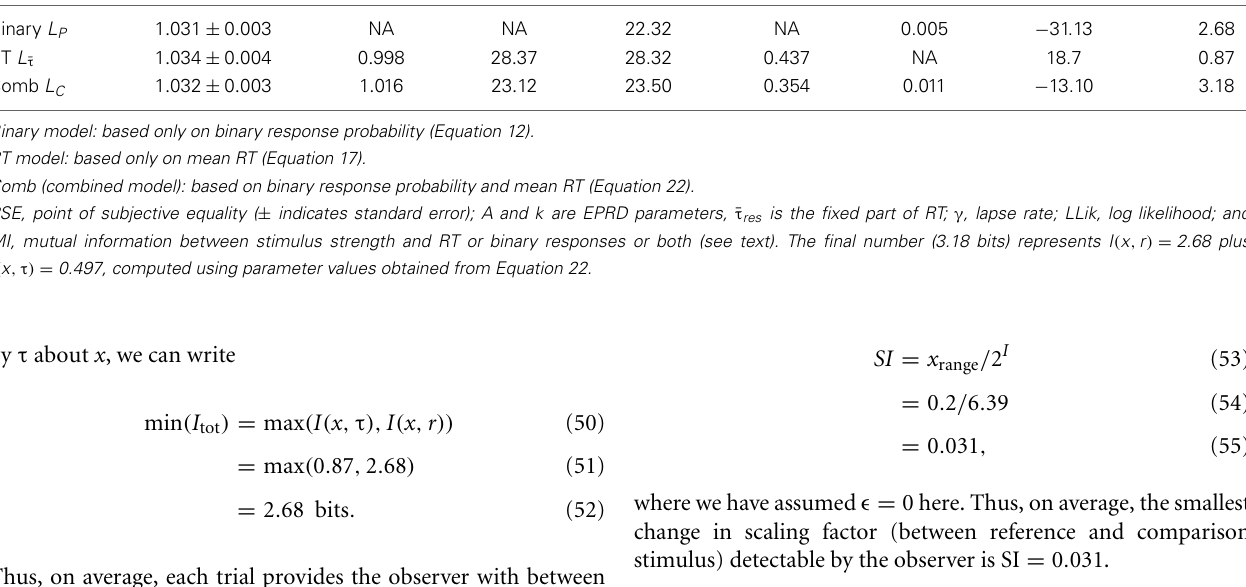
FIGURE 4 | The psychometric function (A) and chronometric function (B), from the face inversion experiment for one observer. The width scaling factor s applied to the comparison image is indicated on the abscissa. The vertical dashed line marks the point-of-subjective-equality (PSE) at s = 1 . 032. (A) Each dot represents the observed proportion of trials for which the observer chose the comparison stimulus, and the fitted psychometric function is defined in Equation 6. (B) Each dot represents the RT of a single trial for the same responses as in